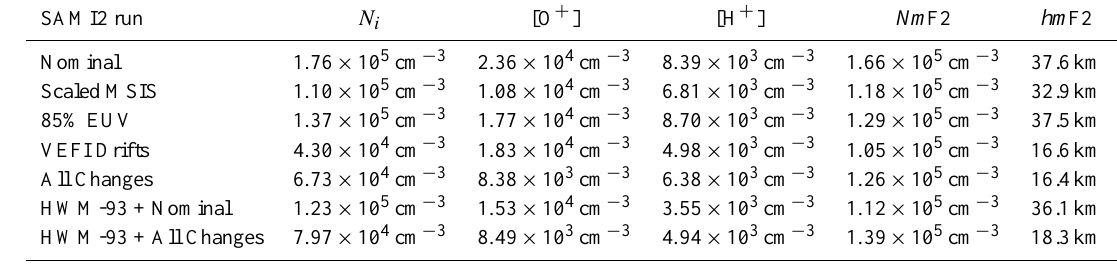
Fig. 8. The median h m F 2 values derived from F3/C, with the vertical bars representing the upper and lower Table 2. RMS Deviations from data. quartiles. The modeled results are the same as Figure 4.